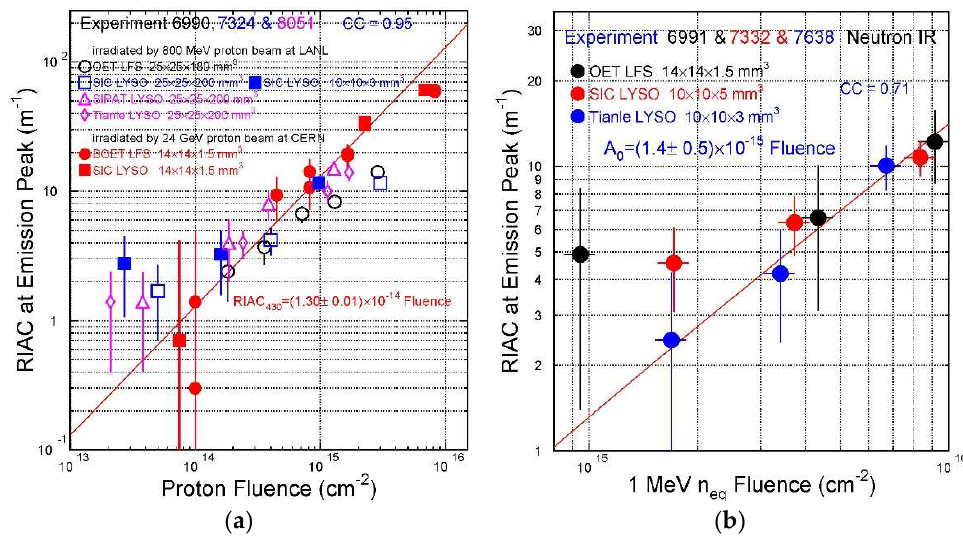
Figure 4. The RIAC values are shown as a function of ( a ) the proton fluence [25–27,35] and ( b ) the one MeV equivalent neutron fluence [32] for LYSO/LFS crystals from different vendors irradiated in the proton experiment 6990, 7324 and at the CERN PS-IRRAD experiment and the neutron experiment 6991, 7332, and 7638, respectively.